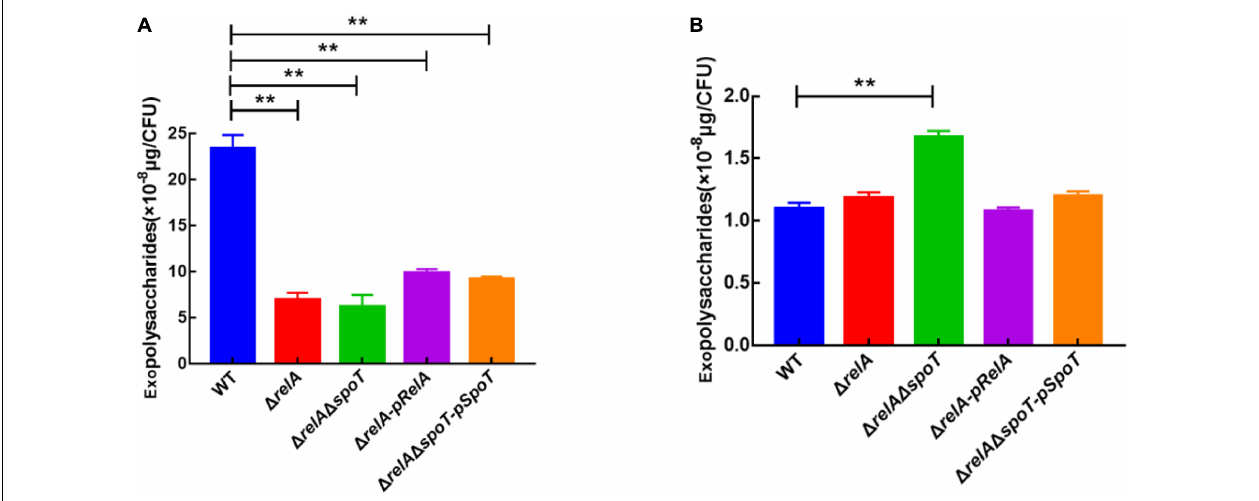
FIGURE 3 | The effects of relA and spoT on EPSs production. The content of EPSs was measured by phenol-sulfuric acid method in WT, (cid:49) relA , (cid:49) relA (cid:49) spoT , (cid:49) relA-pRelA , and (cid:49) relA (cid:49) spoT-pSpoT at 6 (A) and 24 h (B) , respectively. Three separate experiments were performed with biological triplicates each, and results were presented as mean ± SD ( n = 3). ** indicates p ≤ 0.01.